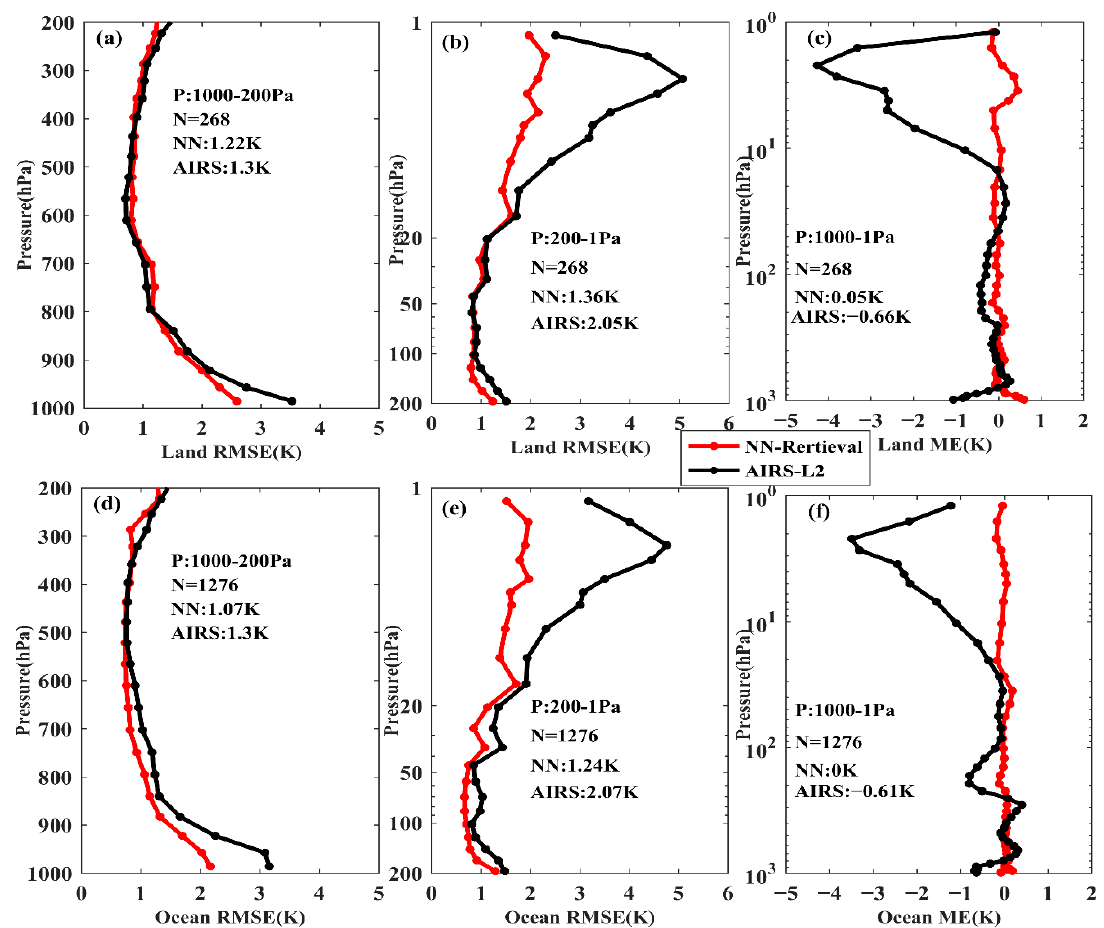
Figure 10. Accuracy comparisons between Aqua/AIRS-L2 temperature products and NNs retrievals versus ERA5. ( a – c ) The RMSE and ME of the temperature on land, respectively. ( d – f ) The RMSE and ME of temperature on ocean, respectively. The red dotted line represents the comparison between the retrievals from NNs and ERA5 data, the black solid line represents the comparison between AIRS products and the ERA5 data.